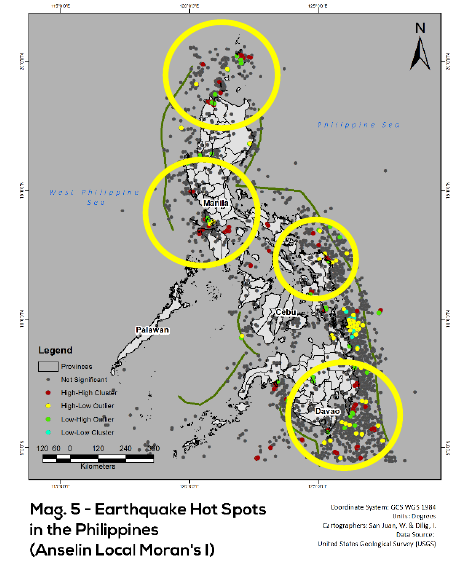
Figure 11. Mag.5-Earthquake Clusters in the Philippines